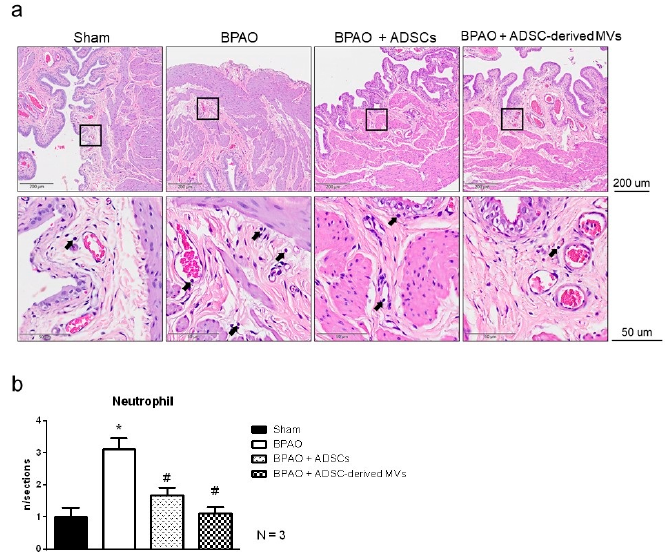
Figure 8. Histological staining and analyses in separated group. In the top panel, ( a ) showed the H&E staining among groups. In the bottom panel, ( b ) showed analysis of neutrophil counts. The results showed BPAO group have the highest number of neutrophil infiltration among the four groups (* p < 0.05). The neutrophil counts of BPAO + ADSCs groups and BPAO + ADSC-derived MVs group are significantly less than BPAO group ( # p < 0.05).